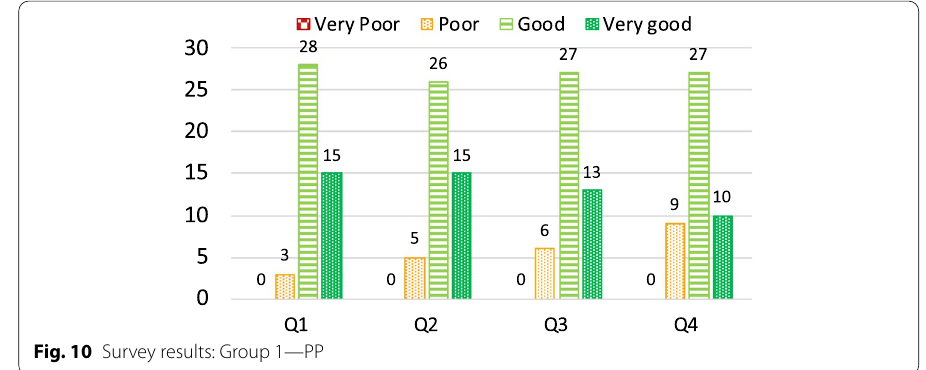
Fig. 10 Survey results: Group 1—PP